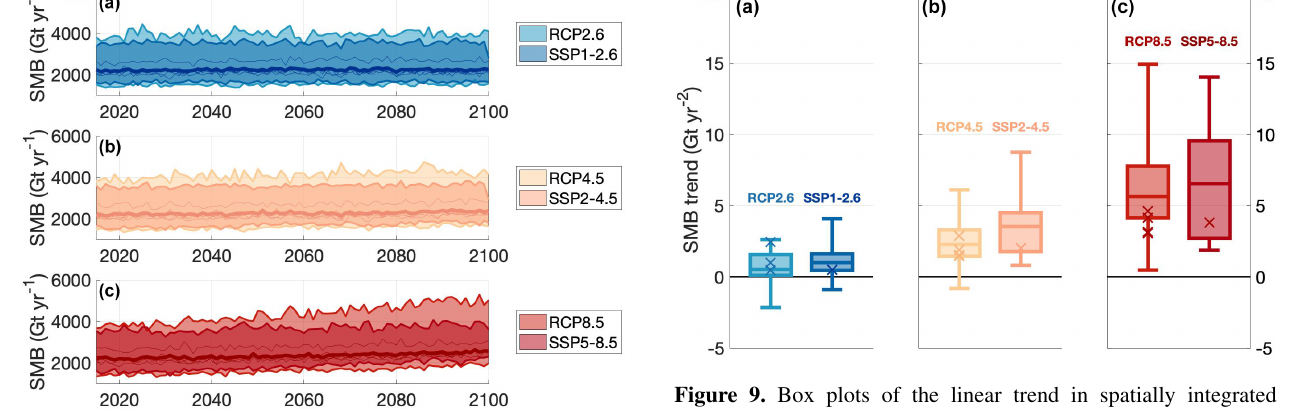
Figure 9. Box plots of the linear trend in spatially integrated AIS SMB from 2050–2100 for (a) RCP2.6 and SSP1-2.6 (blue), (b) RCP4.5 and SSP2-4.5 (yellow), and (c) RCP8.5 and SSP5-8.5 (red). The five darker x’s denote the five models – GISS E2 H CC, GISS E2 R CC, MPI ESM LR, and MPI ESM MR from CMIP5 and MRI ESM2 from CMIP6 – among the eight best scoring models with the appropriate and necessary information for direct compari- son of future projections.